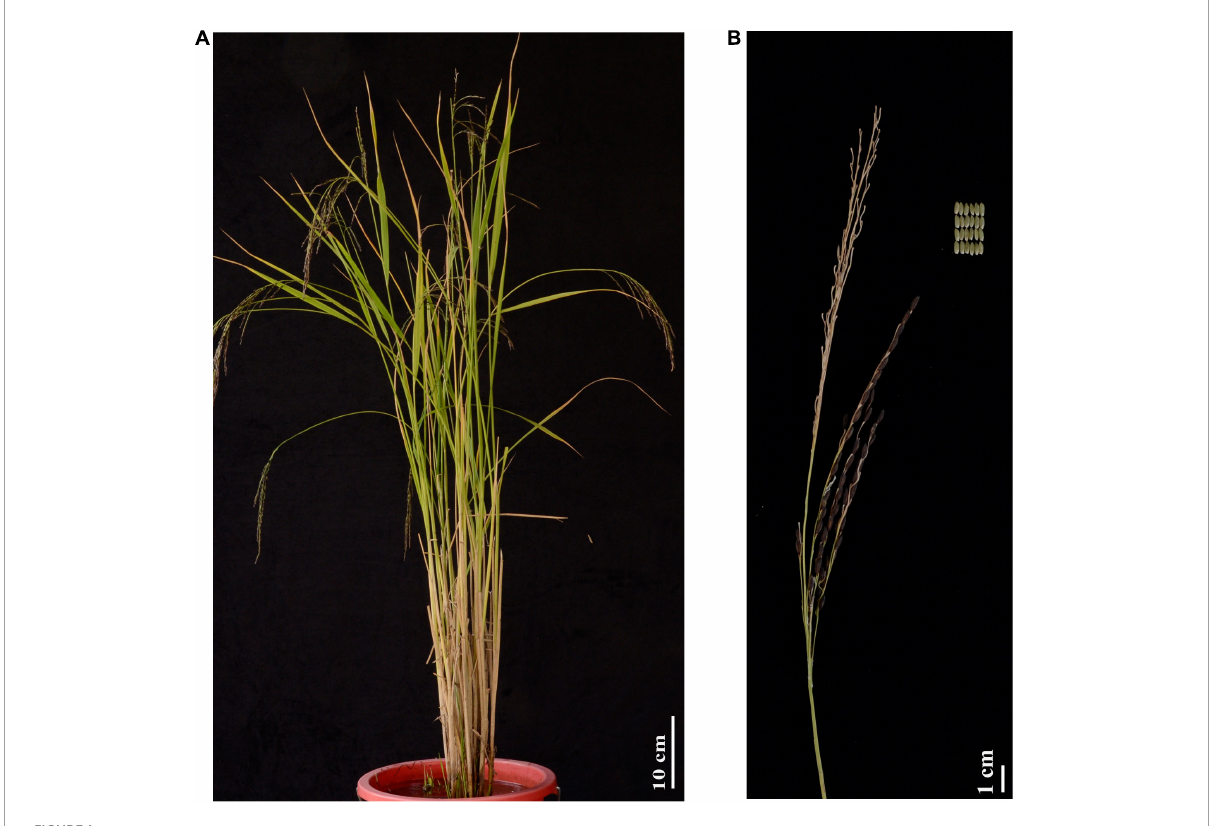
FIGURE1 Phenotypic analysis of LM8. (A) Whole plant phenotype. (B) Panicle morphology and caryopsis color at the fully ripe